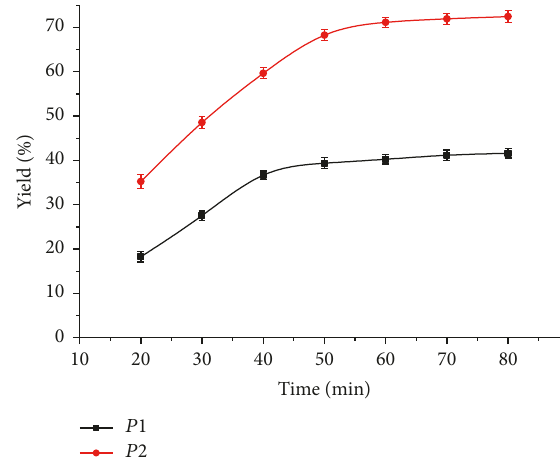
Figure 6: Effect of ultrasonic time on NFCs yield.